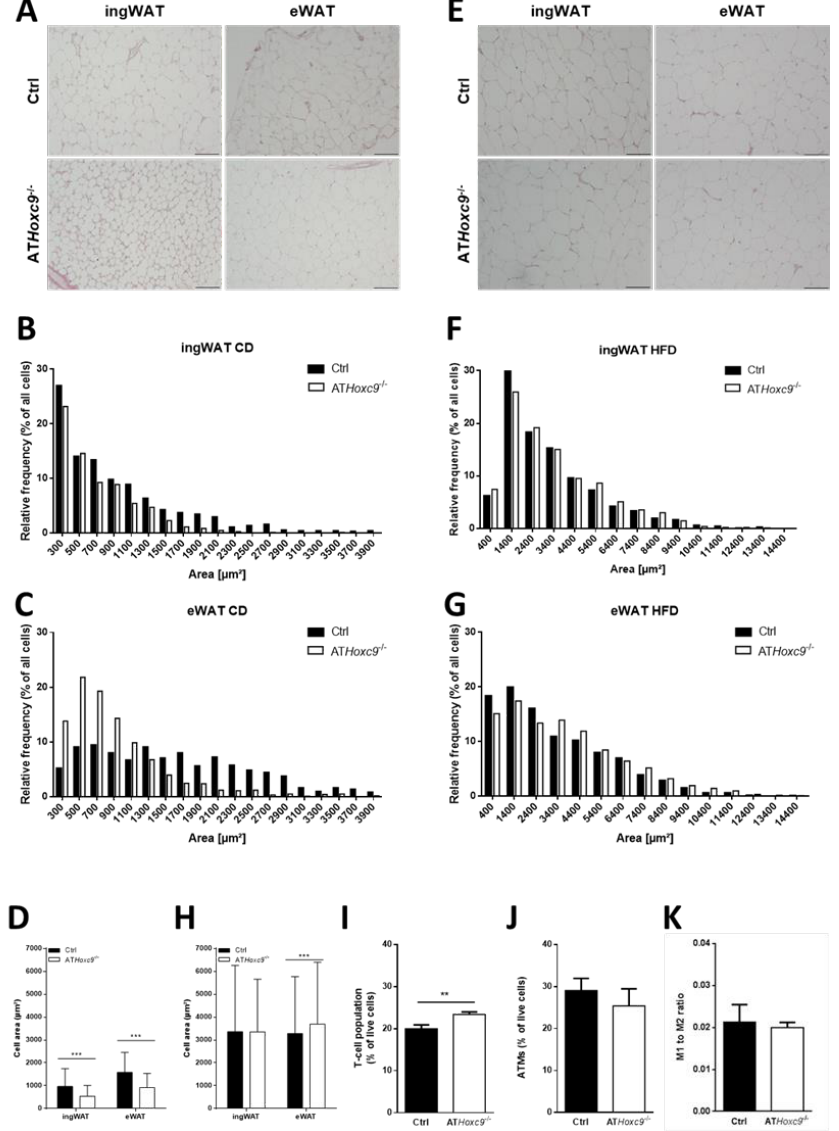
Figure 4. Consequences of Hoxc9 targeting on adipose tissue morphology. ( A ) H&E staining of ingWAT and eWAT under chow diet (CD) Ctrl vs. AT Hoxc9 - / - . Ten times magnification, bar size = 100 µ m. ( B , C ) Adipocyte area measurements represented as fractions of total amount of counted cells. ( D ) Cell area measurements of ingWAT and eWAT from male mice under CD calculated with BZ-X800 Analyzer Software. n(ingWAT, Ctrl) = 1408, n(ingWAT, AT Hoxc9 - / - ) = 1676, n(eWAT, Ctrl) = 752, n(eWAT, AT Hoxc9 - / - ) = 1192. ( E ) H&E staining of ingWAT and eWAT under HFD Ctrl vs. AT Hoxc9 - / - . Ten times magnification, bar size = 100 µ m. ( F , G ) Adipocyte area measurements represented as fractions of total amount of counted cells. ( H ) Cell area measurements of ingWAT and eWAT from male mice under HFD calculated with BZ-X800 Analyzer Software. n(ingWAT, Ctrl) = 1137, n(ingWAT, AT Hoxc9 - / - ) = 1017, n(eWAT, Ctrl) = 1394, n(eWAT, AT Hoxc9 - / - ) = 1337. ( I – K ) Analysis of the immune phenotype shows no di ff erences with respect to adipose tissue macrophage (ATM) populations and the M1 to M2 macrophage ratio in lean male mice. Viable CD45 + (CD, Cluster of di ff erentiation) and F4 / 80 + cells were defined as ATMs. Subpopulations could be further distinguished into M1 (CD11c + ; CD206 − ) and M2 (CD11c − ; CD206 + ). Viable CD45 + and CD3 + cells were defined as T lymphocytes, further divided into T helper cells (T H ; CD4 + ; CD8 − ) and cytotoxic T cells (T C ; CD4 − ; CD8 + ). Gating strategies are shown in Figure S3. n = 6–10 mice each group. Data represent the mean ± SEM. ** p < 0.01, *** p <